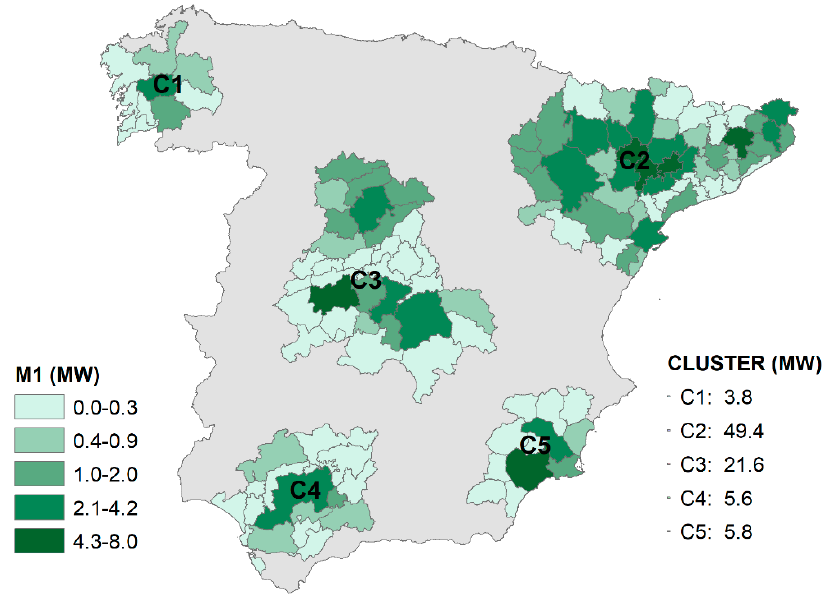
Figure 3. Geographical distribution of the power potential and clusters’ power for mixture M1.